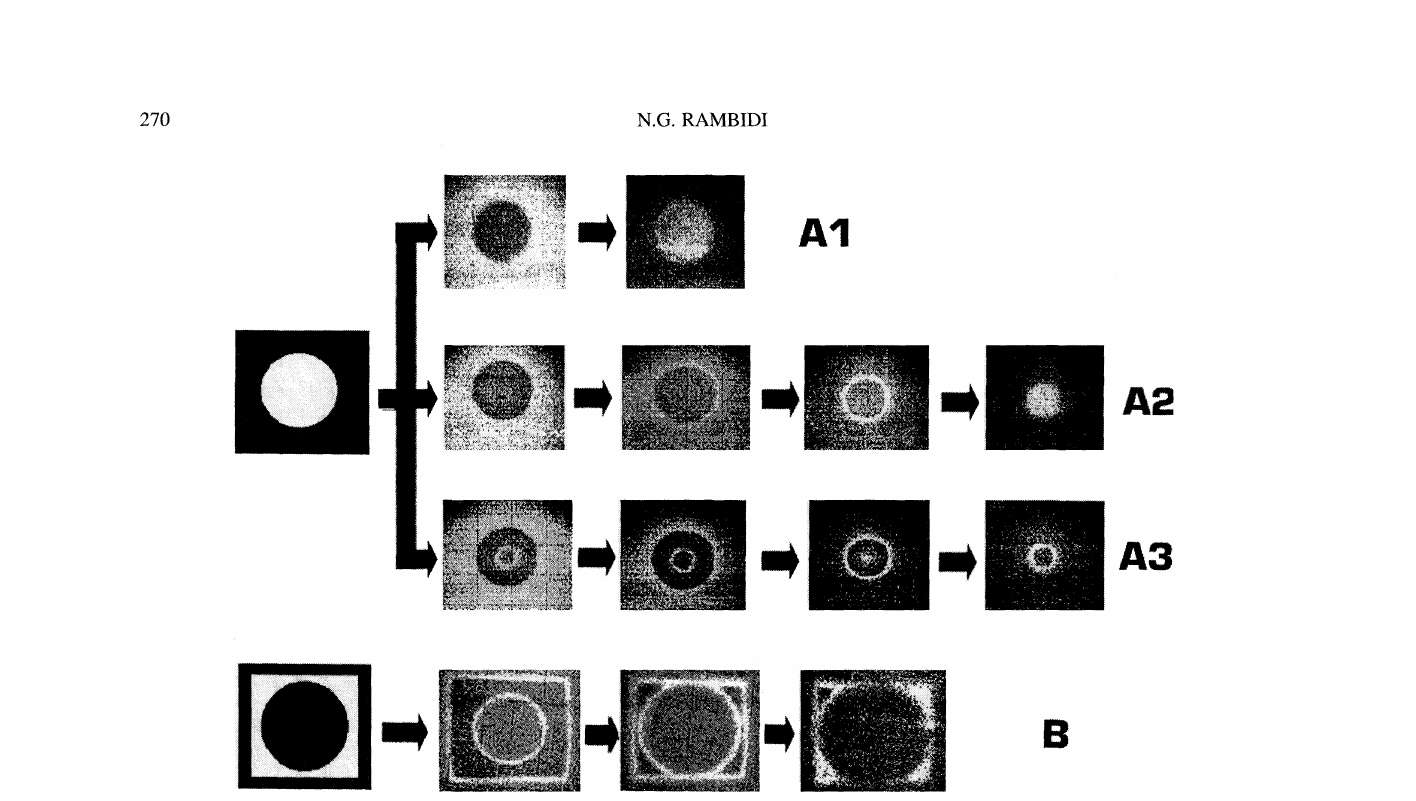
FIGURE 2 Temporal evolution of simple images (initial images are to the left) in thin layers of light-sensitive Belousov-Zhabotinsky type media depending on the state of the medium (A1-A3) and on the character of the input image